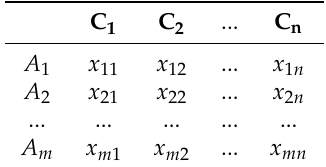
Table 3. Decision